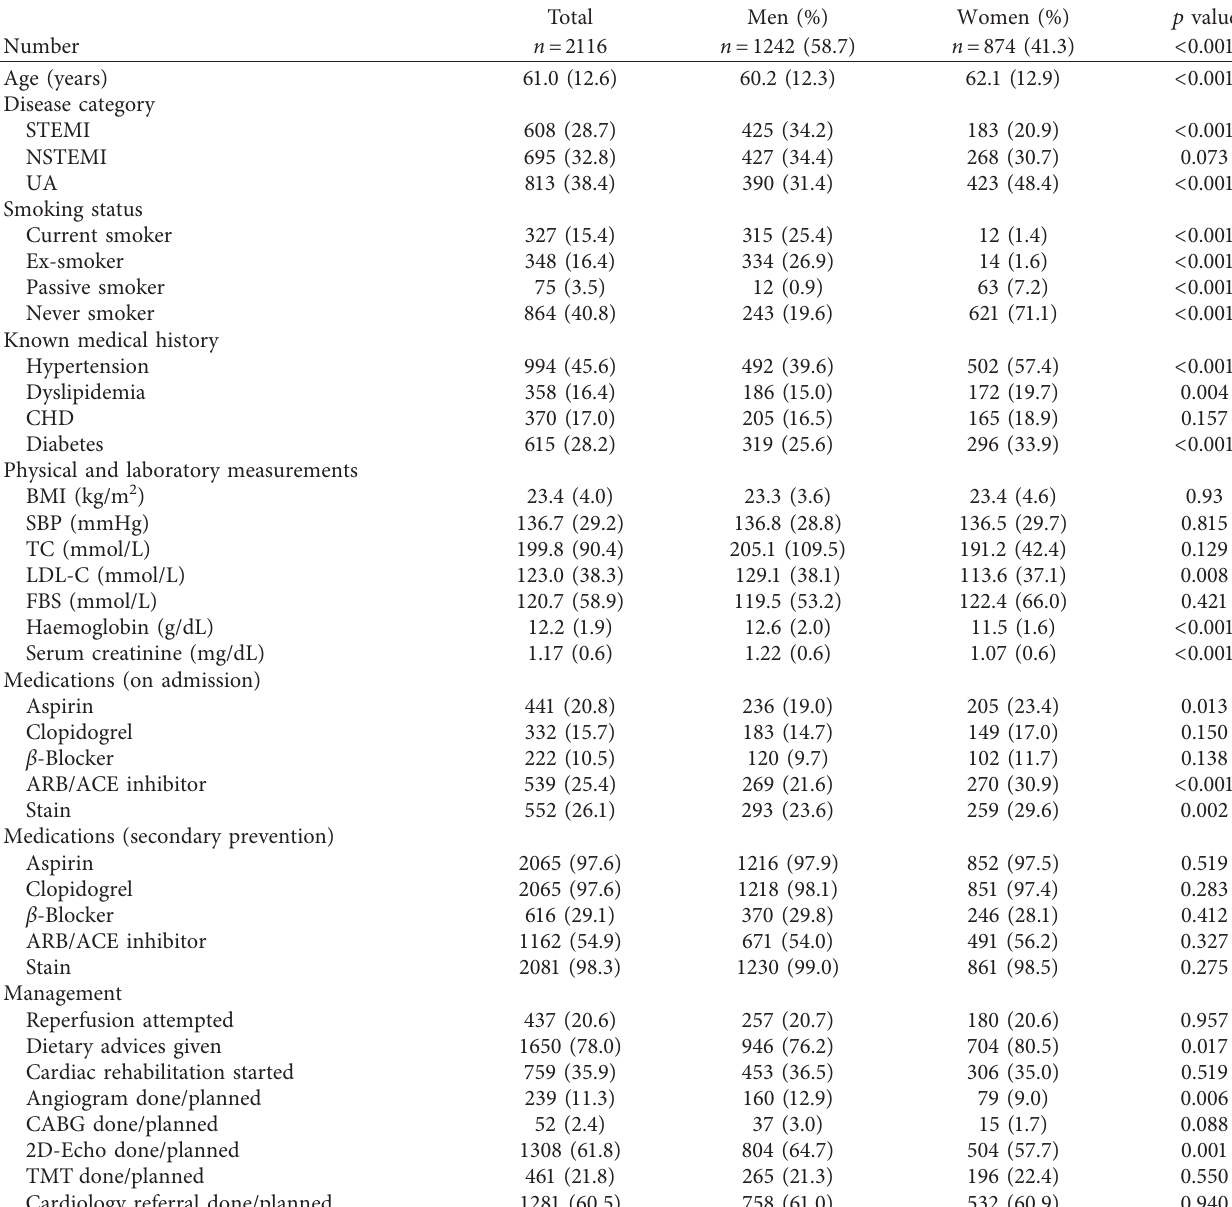
Table 1: Patient characteristics and cardiovascular risk factors and the management stratified by